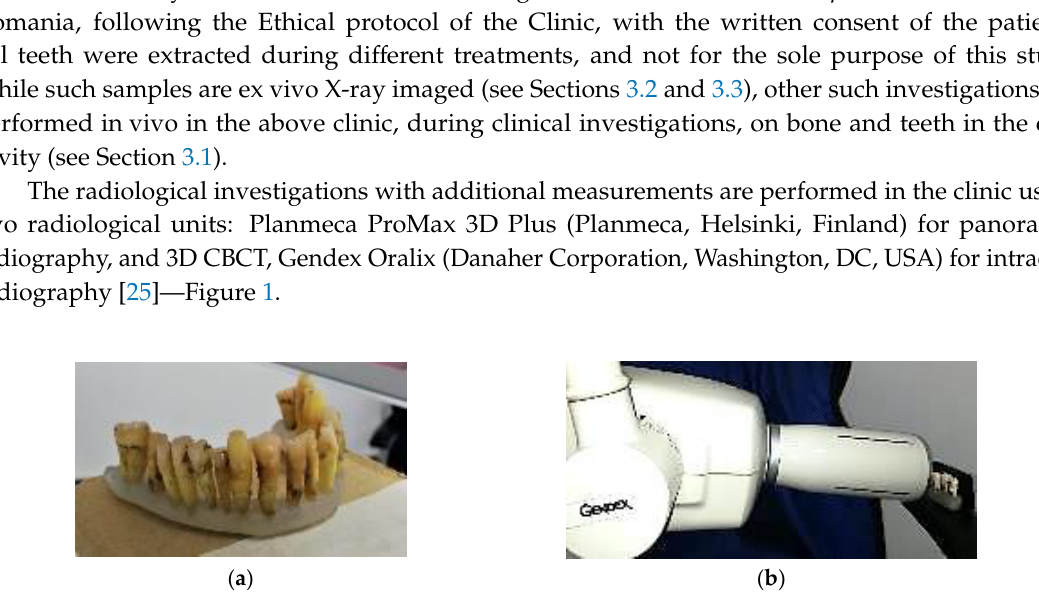
Figure 1. ( a ) Prepared teeth for X-ray investigations; ( b ) teeth positioned in the X-ray unit Gendex Oralix (Danaher Corporation, Washington DC, USA), ready for